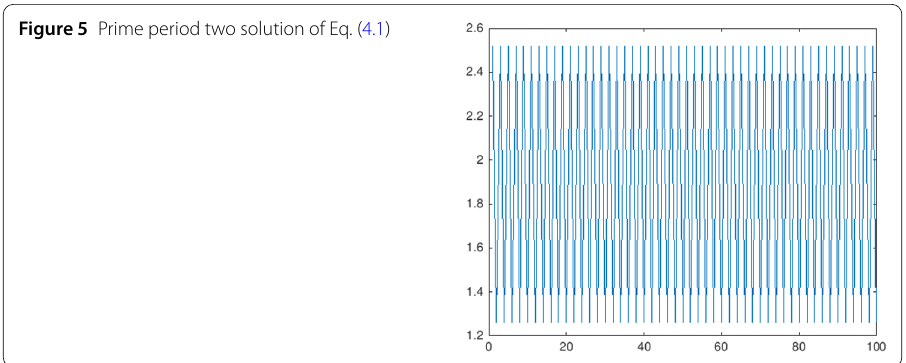
Figure 5 Prime period two solution of Eq.